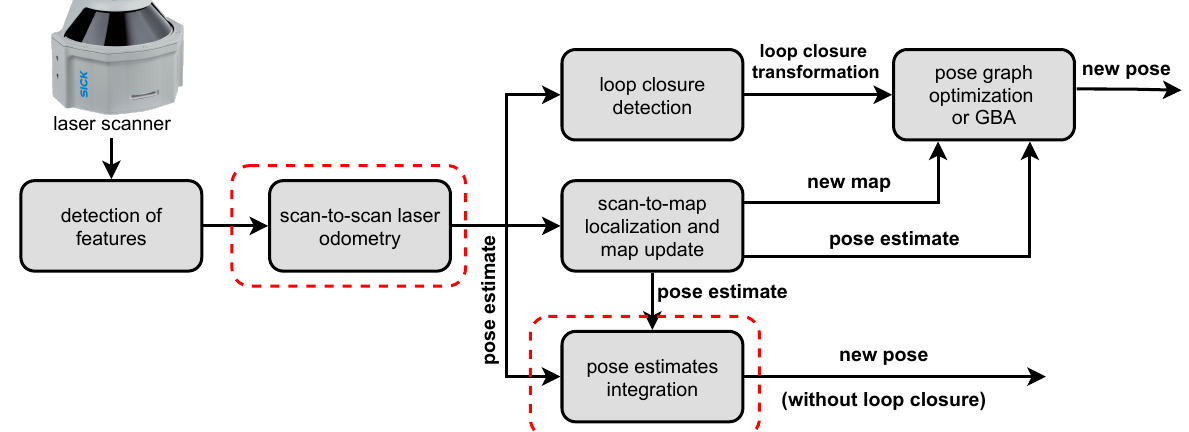
Figure 1. Block scheme of the general PlaneLOAM architecture. Blocks in dotted-line borders do not contain any significant changes in relation to